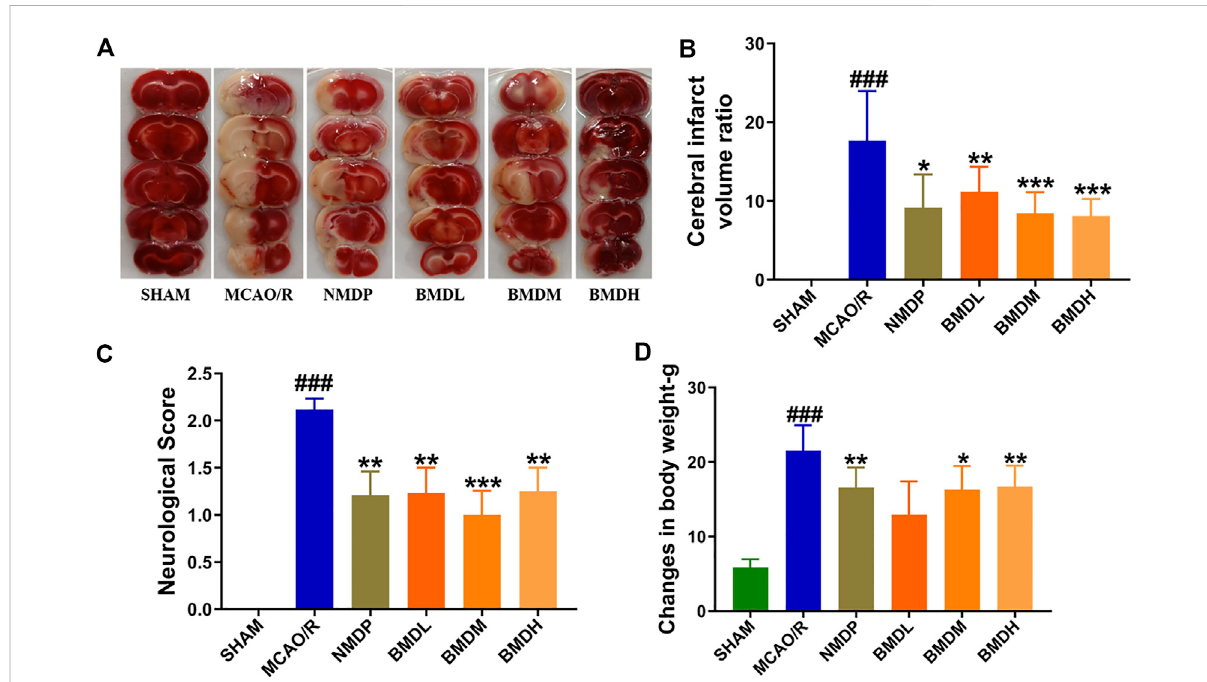
FIGURE 1 Cerebral infarction evaluation ( n = 8). (A) TTC staining of brains. (B) Cerebral infarct volume ratio examination. (C) Neurological de fi cit score assessment. (D) Changes in body weight determination. Data were expressed as the mean ± SD. *p < 0.05, **p < 0.01, ***p < 0.001 relative to the MCAO/R group; ### p < 0.001 relative to the SHAM